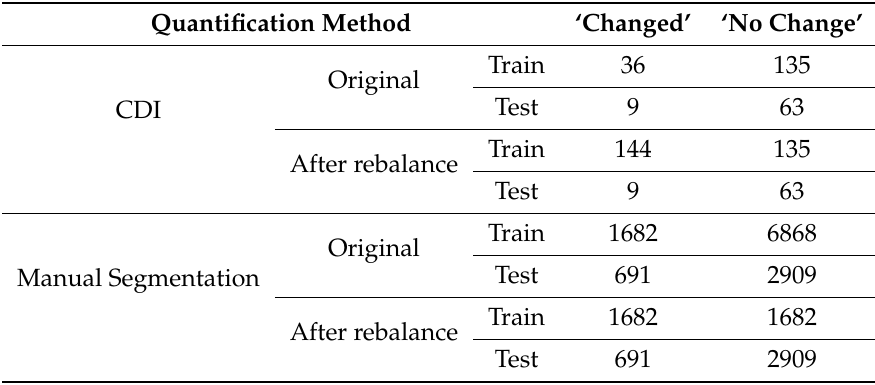
Table 3. Sample distribution in experiment